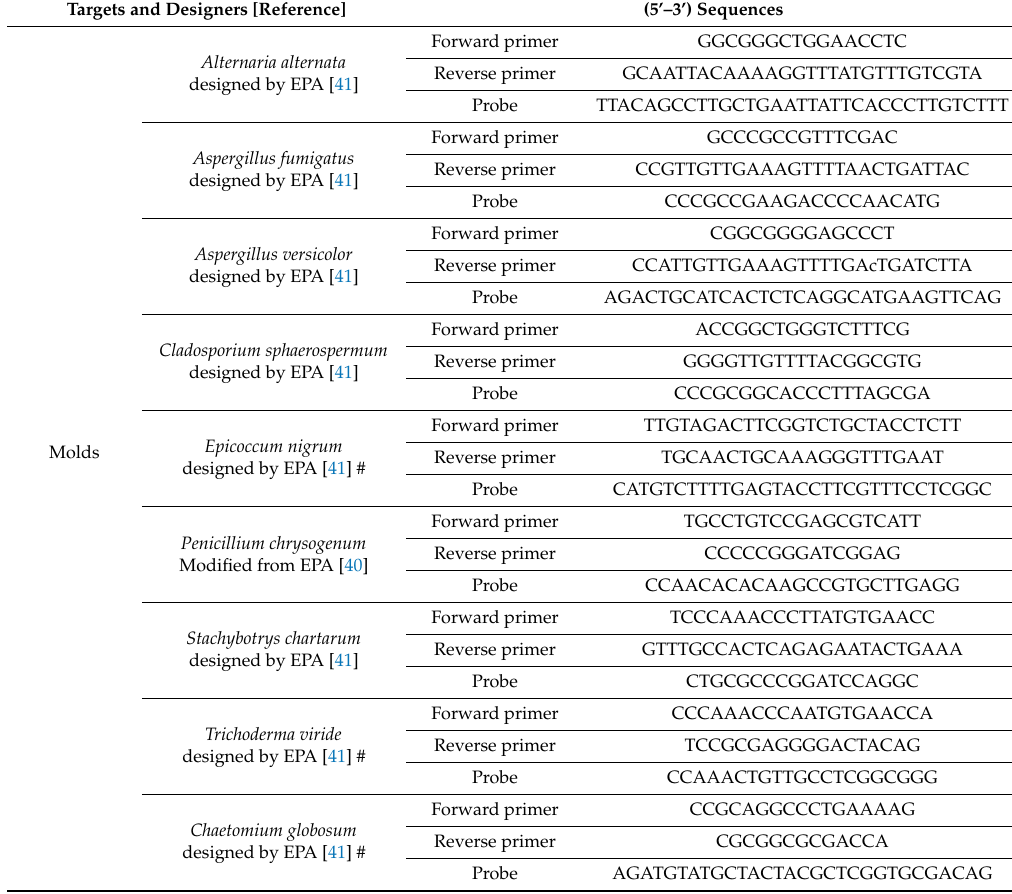
Table 1. Primers and probes sequences (and their references) used in this